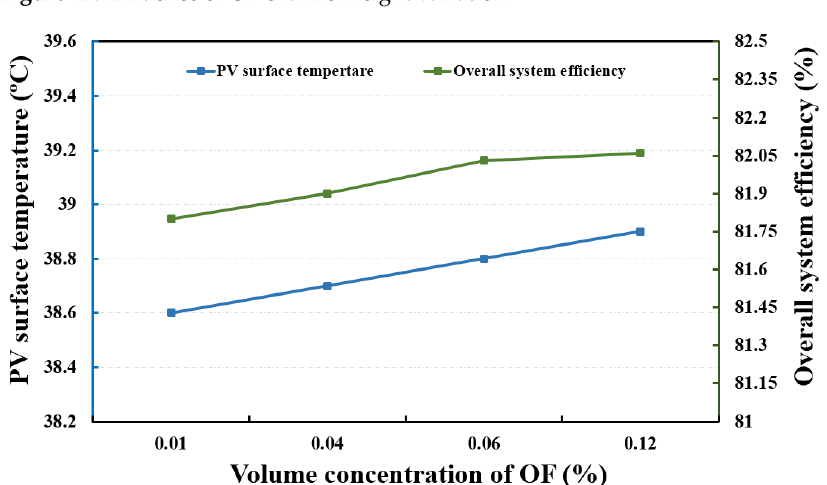
Figure 12. Influence of OF channel height variation.